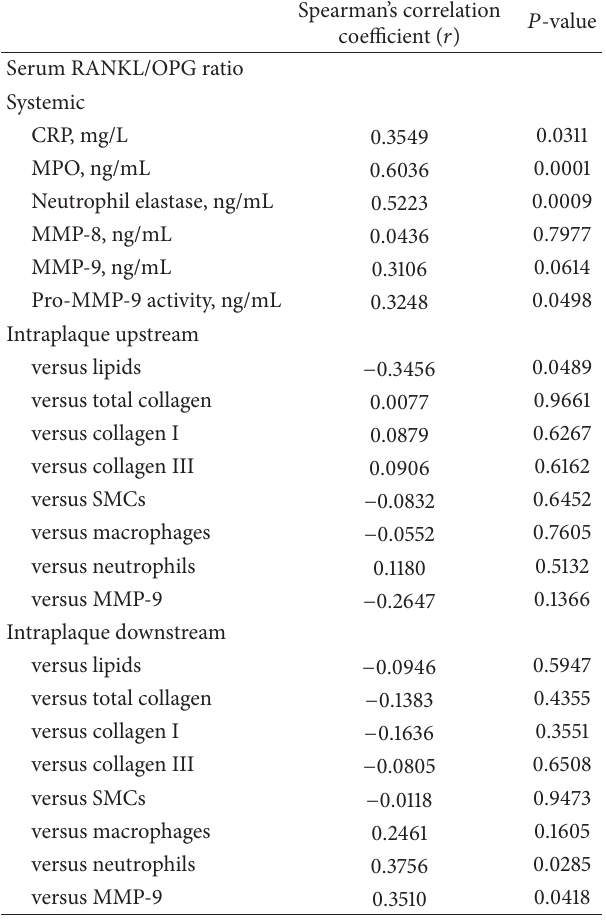
Table 6: Spearman rank correlation between serum RANKL/OPG ratio and systemic and intraplaque parameters (upstream or down- stream regions) of